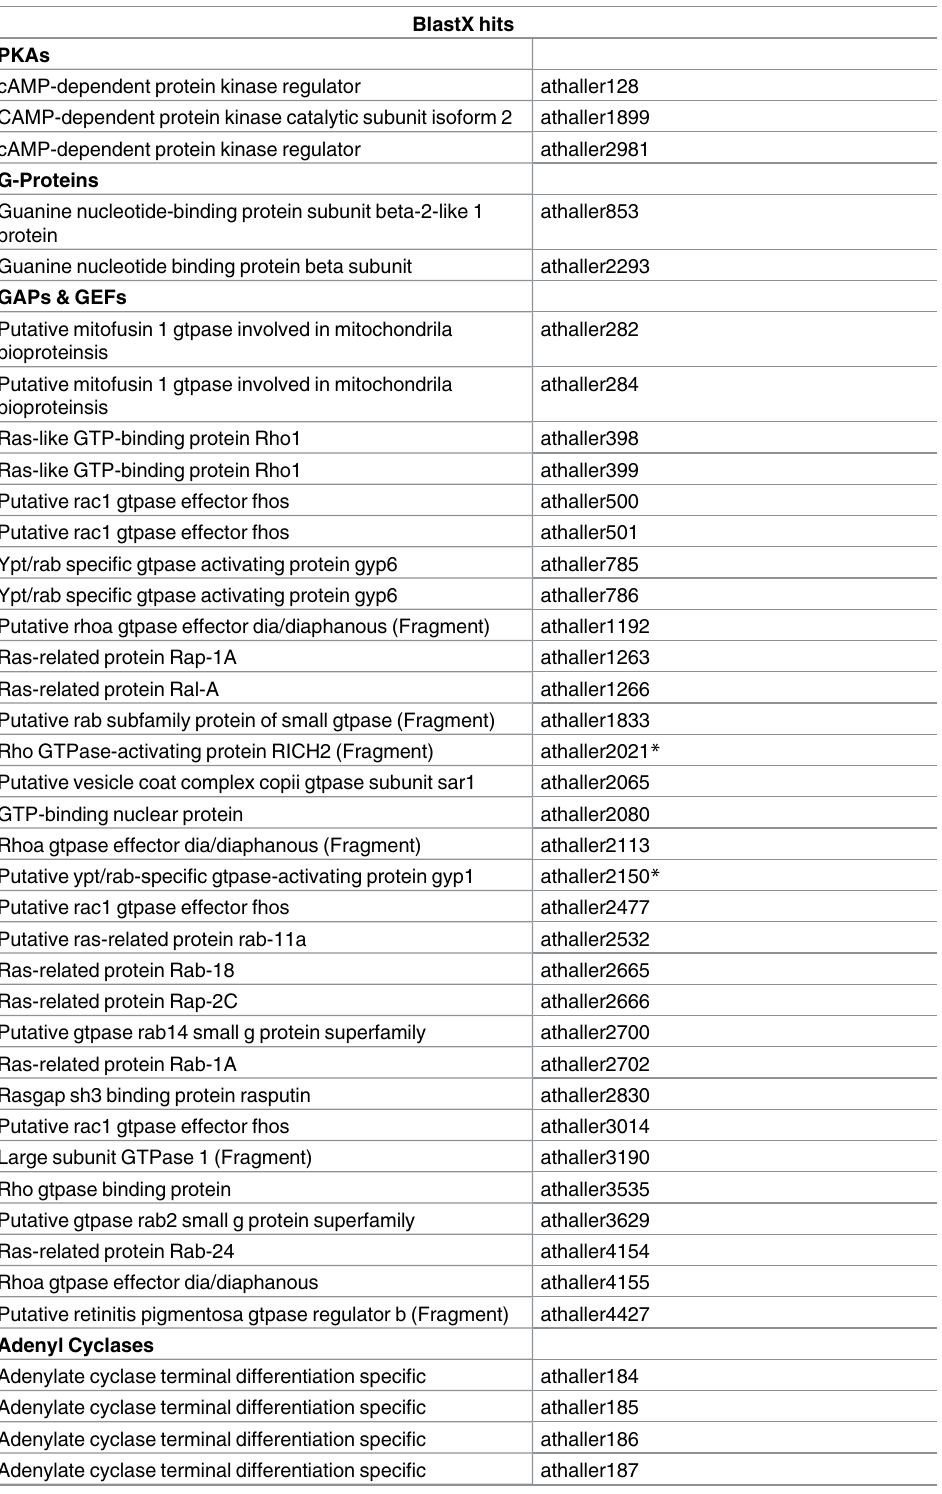
Table 5. Predicted GPCR-related proteins. Cattle tick foreleg transcripts annotatedas encodingproteins related to GPCR